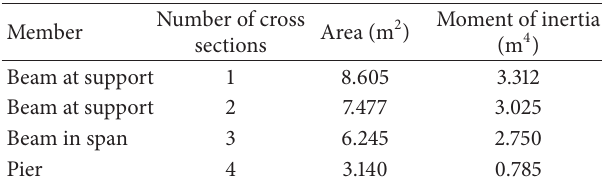
Table 1: Main data of the concrete girder